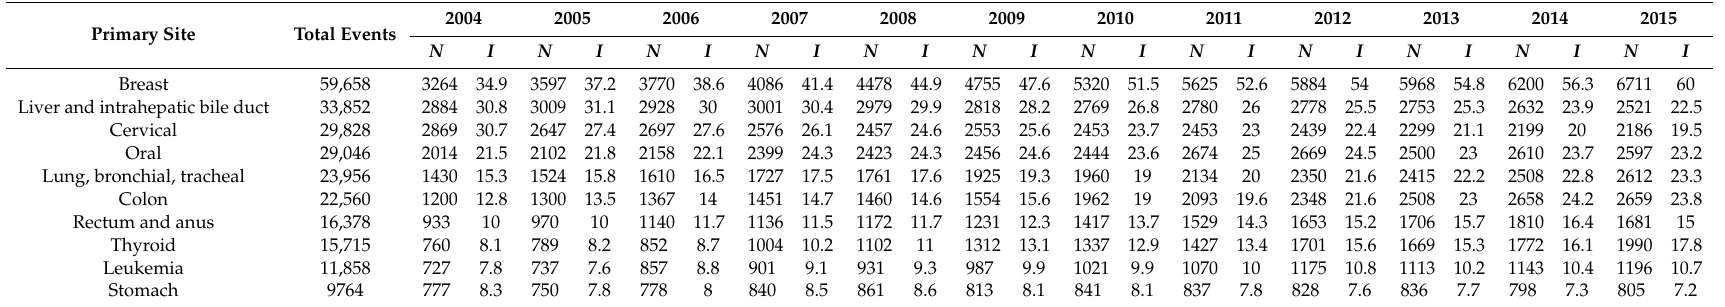
Table 2. Annual incidence of first-ever cancer diagnosis of the top 10 cancer types among insured workers in Taiwan, 2004–2015. Primary